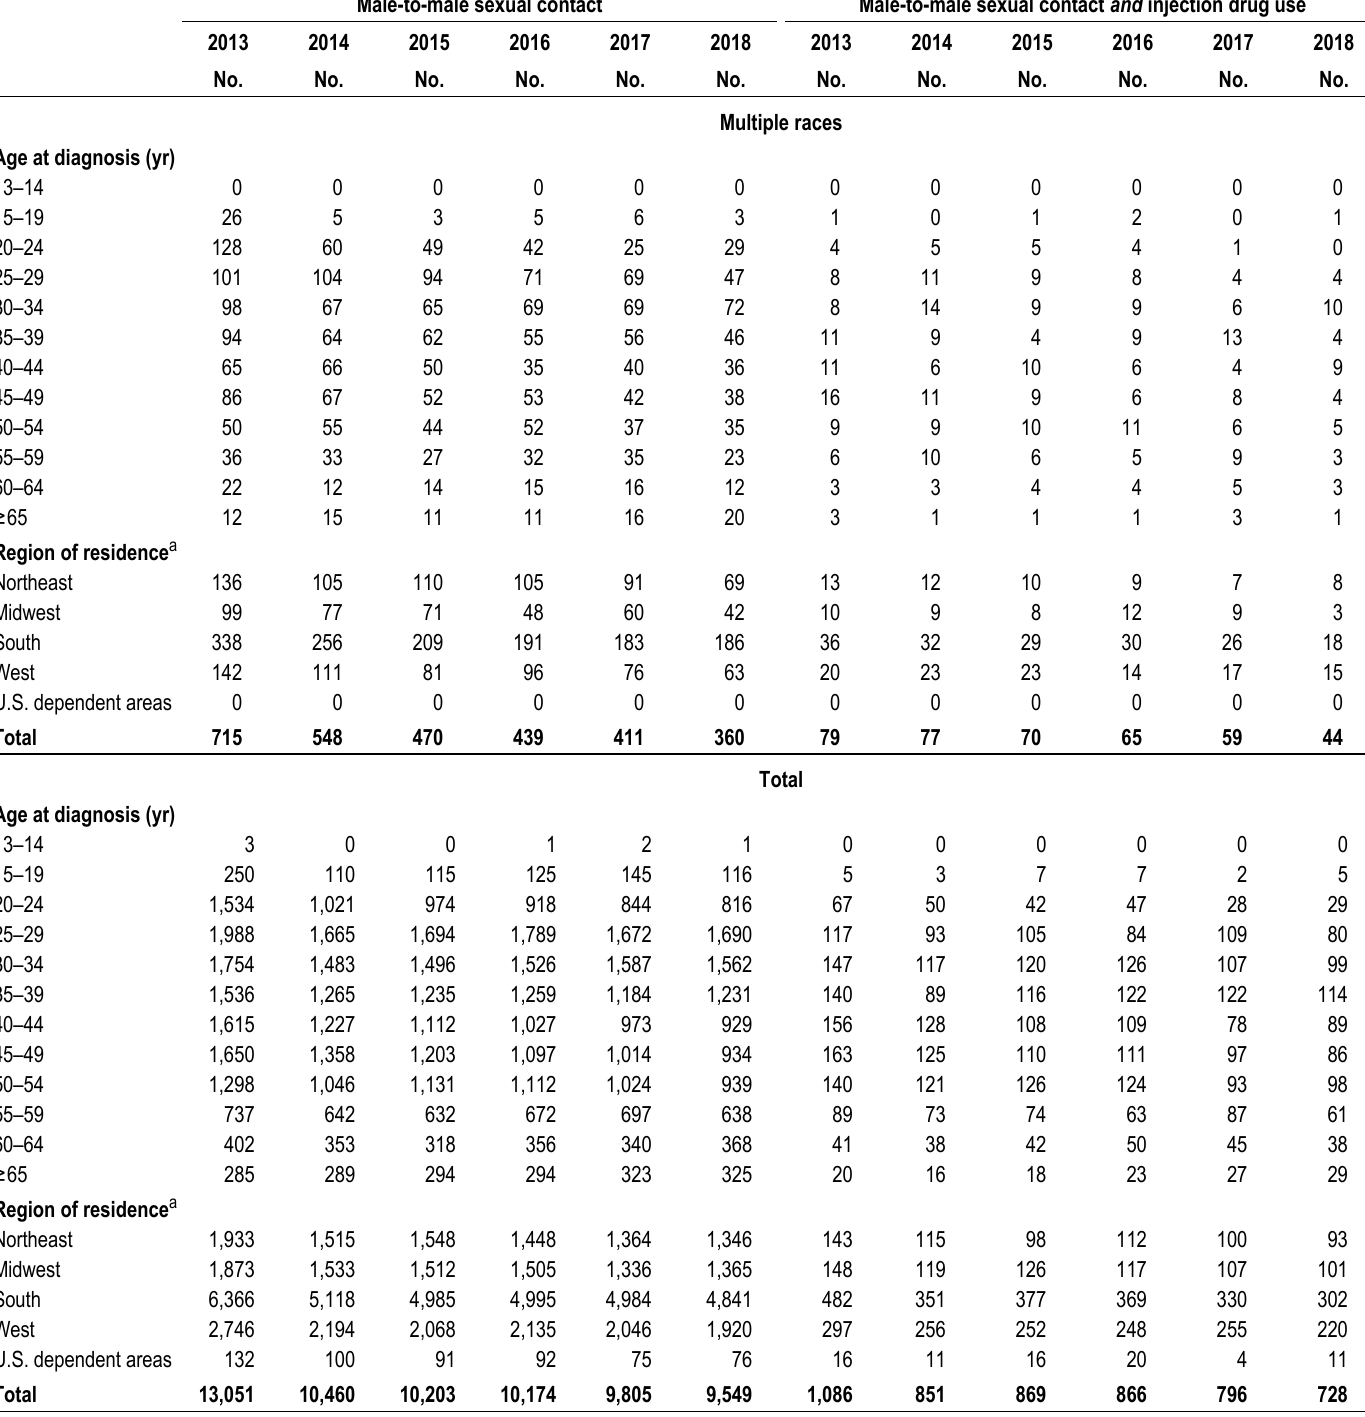
Table 10b. Stage 3 (AIDS) attributed to male-to-male sexual contact and male-to-male sexual contact and injection drug use, by selected characteristics, 2013–2018—United States and 6 dependent areas